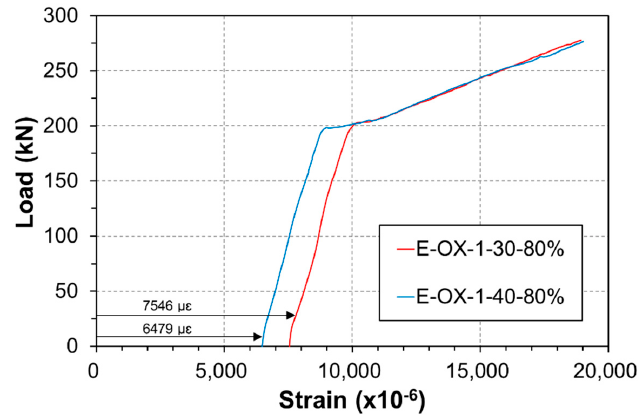
Figure 8. Load-strain relationship at CFRP (Concrete strength).